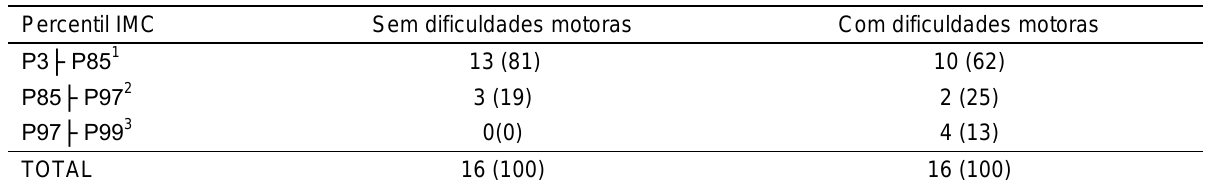
Tabela 3. Frequência absoluta e relativa (entre parênteses) de crianças nos grupos com e sem dificuldades motoras de acordo com a classificação do IMC em